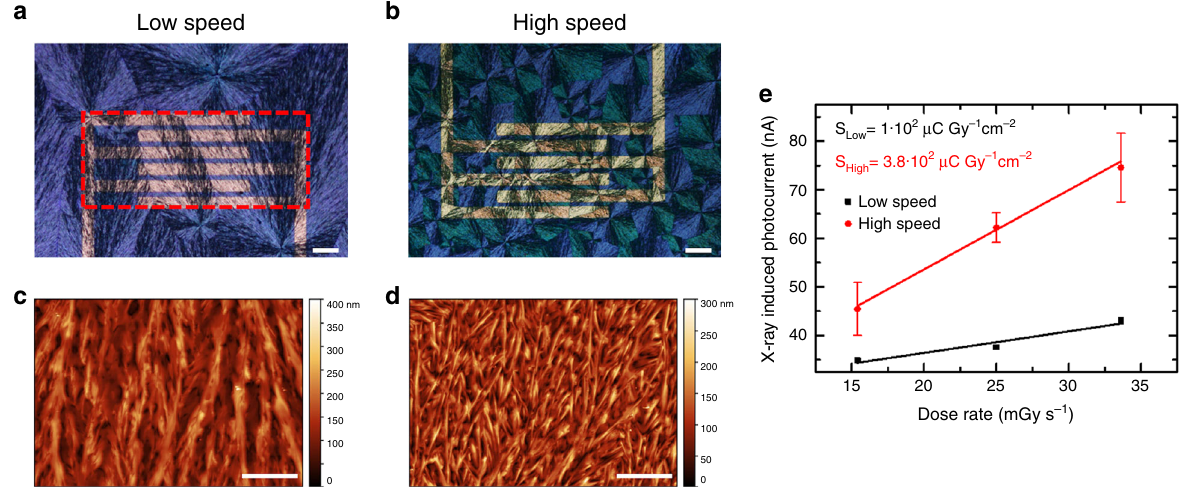
Fig. 2 Impact of fi lm morphology (grain size/density) on X-ray detection sensitivity. Cross-polarized optical microscope images and AFM topography images of pristine TIPS-pentacene thin fi lms deposited by BAMS at a , c low speed (4 mm s − 1 ) and b , d high speed (28 mm s − 1 ). The dashed red box in a indicates the pixel area used for the calculation of the sensitivity. Scale bar: 100 µ m. e X-ray induced photocurrent versus dose rate plot for the two types of fi lms and relative calculated sensitivity, obtained under irradiation by a Mo-target X-ray tube. The error bars refer to the statistical fl uctuations of the signal amplitude over three on/off switching cycles of the X-ray beam in the same